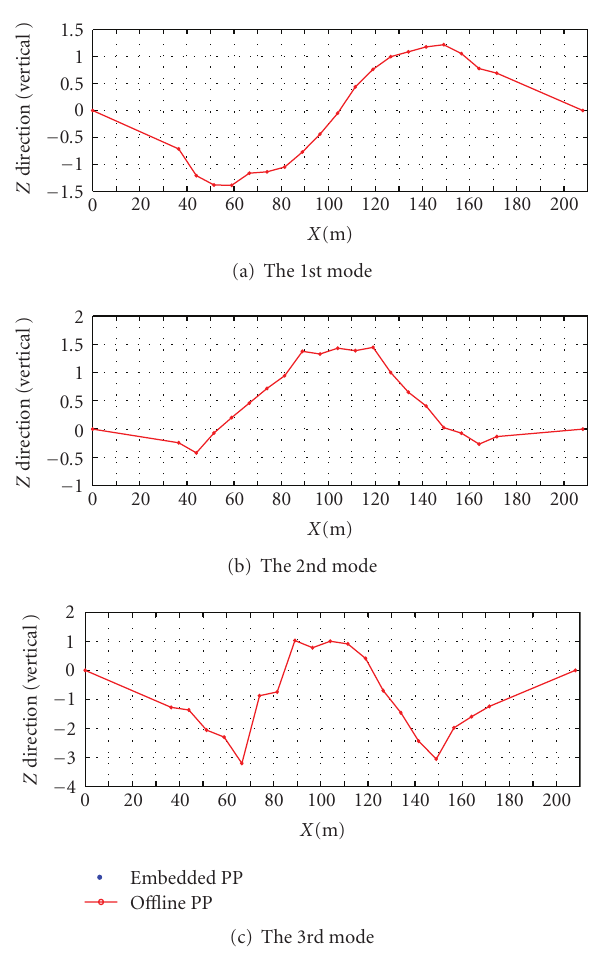
Figure 9: Comparison of mode shapes estimated by embedded and o ffl ine PP.